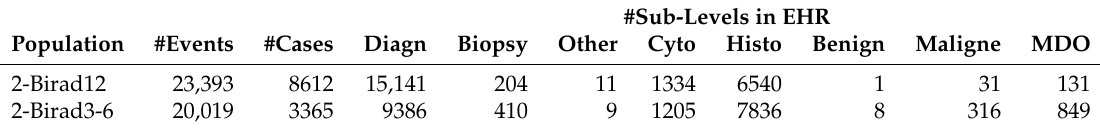
Table 5. Overview of the selected sub-populations with second-level